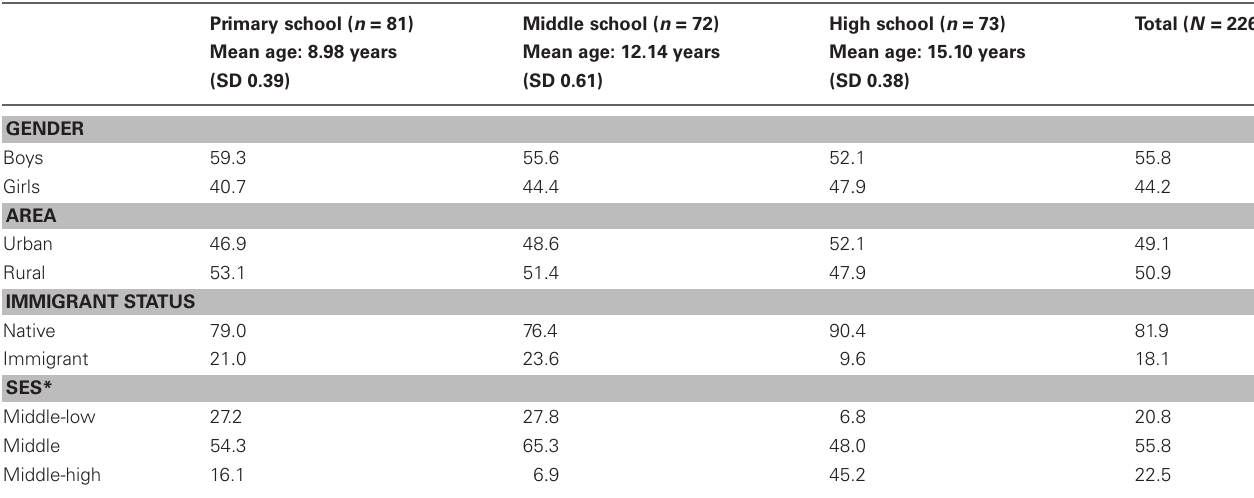
Table 1 | Sample characteristics as